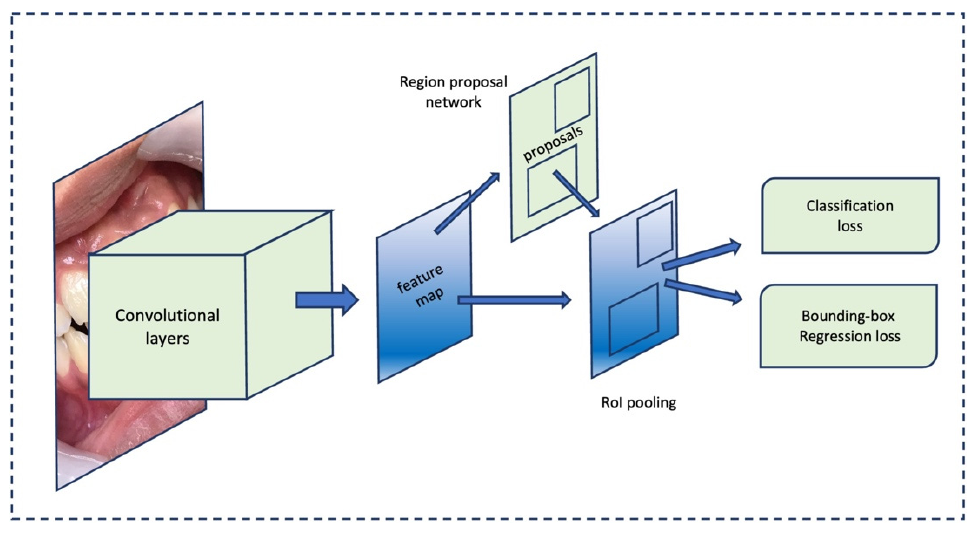
Figure 3. Faster-RCNN architecture.